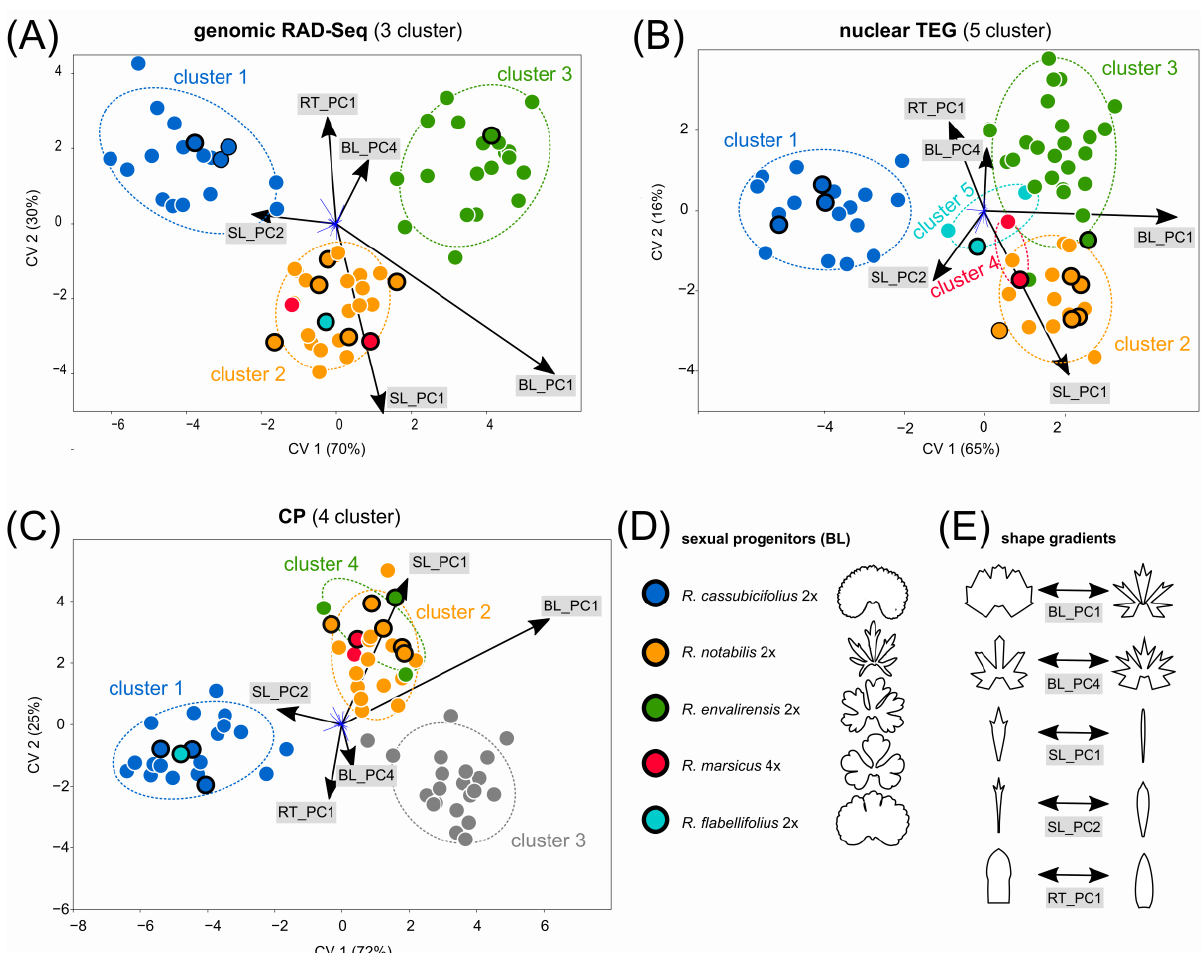
Figure 4. Morphological variation among sexual progenitors and polyploid apomictic derivative taxa with respect to different NGS backgrounds. Canonical variate analysis (CVA) was applied for the clustering of sixty-six populations based on the concatenated trait datasets (BL + SL + RT) and according to their assignment into clusters as inferred from genomic RAD-Seq ( A ), nuclear TEG ( B ), and CP ( C ) NGS-data (see also Materials and Methods for genomic cluster details). Each dot in the CVA scatter plots ( A – C ) represents a single population, and the colors reflect assignments into the RAD-Seq, TEG, and CP clusters (Table S1), respectively. Typical basal leaf morphotypes of the sexual species are shown in ( D ), and the best separating morphological trends are shown in ( E ). The coloring of sexual progenitors and clusters follows Figure 2 and [51]. BL = basal leaves; CP = plastid data; CV = canonical variate (explained percentages of shape variation); RAD-Seq = restriction-site associated DNA sequencing; RT = receptacles; SL = stem leaves; TEG = target enrichment nuclear genes.